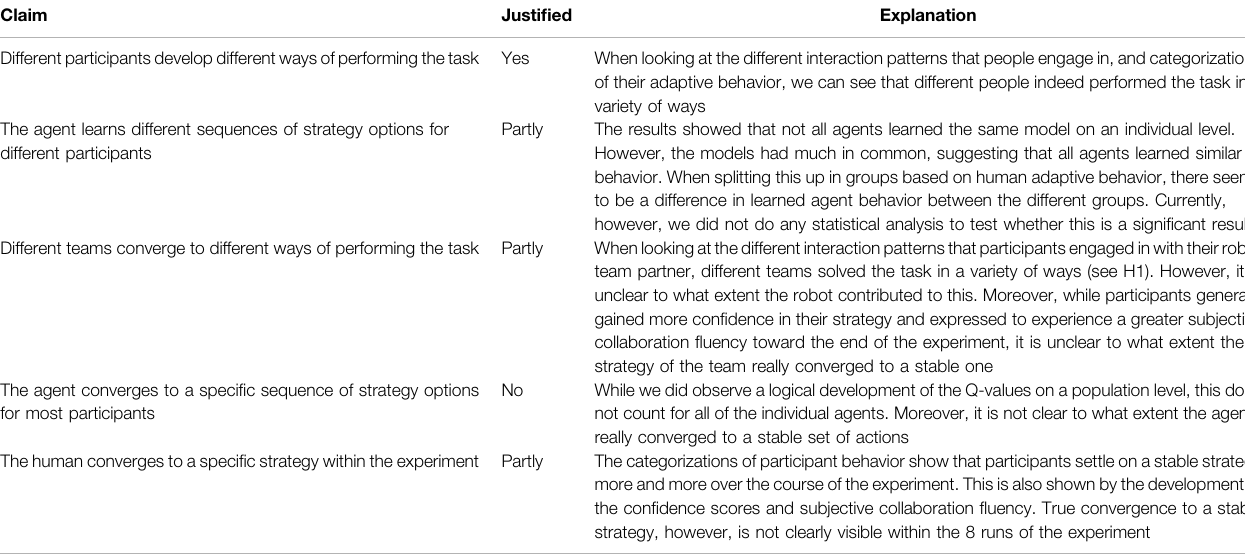
TABLE 5 | The claims as presented in Claims: Expected Observation s that need to be justi fi ed in a co-adaptation experiment, including whether they were validated and an explanation of that conclusion. Claim Justi fi ed